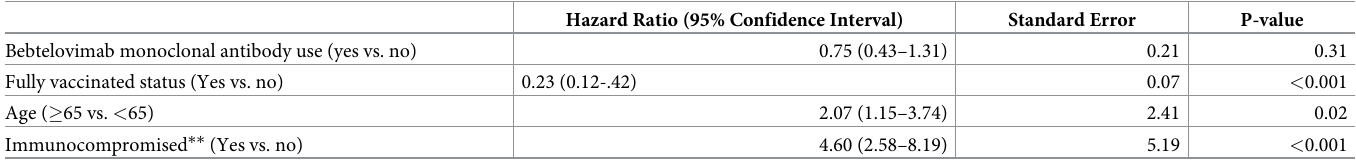
Table 4. Multivariable Cox proportional hazard model * for the composite outcome among the post-propensity matched COVID-19 infected patients in the Banner Healthcare System between April 5, 2022, and August 1,